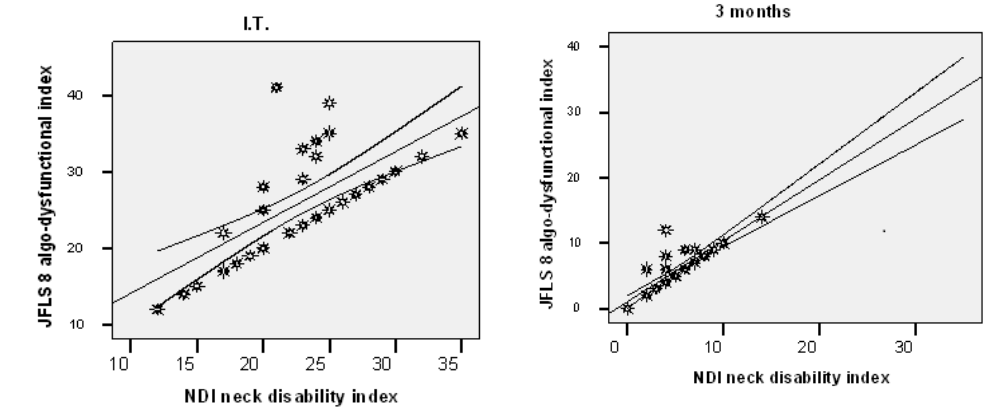
In the experimental group, at the beginning of the study, a significant correlation was found between NDI and JFLS 8 (r = +0.683; p = 0.001). After 3 months of treatment, over 87% of the higher NDI scores were associated with higher JFLS 8 scores (r = +0.872; p = 0.001) (Figure 6).